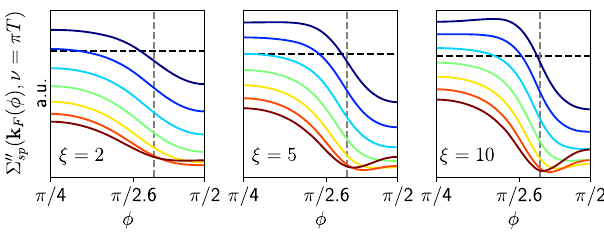
Fig. 2 Model self-energy (4) at the fi rst Matsubara ( π T ) and Fermi vector k F , parameterized by the angle ϕ from π /4 (nodal direction) to π /2 (antinodal direction) for various values of the vertex Γ c = e ı κ . The complex phase is turned from κ = 0 (brown) to κ ¼ (cid:2) π of π . Panels correspond to the different correlation lengths ξ as indicated. 12 Vertical lines show the hot